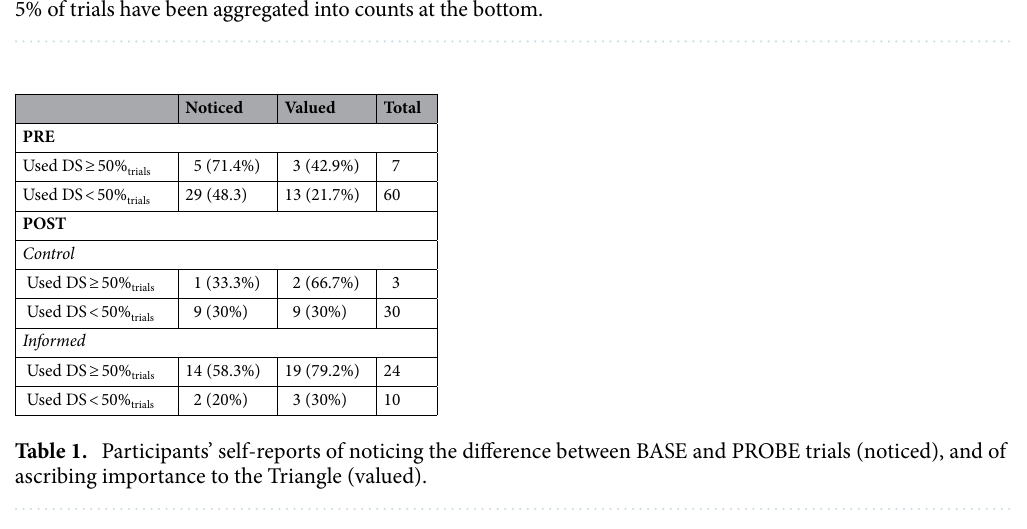
Figure 2. Shortcut-use during the LS-DS task. Mean proportion of trials that a shortcut (DS or SS) was used, for each subject in Informed and Control conditions, in PRE and POST trial blocks. Solid and dashed lines represent group means and standard deviations, respectively. Participants who used the shortcut in fewer than 5% of trials have been aggregated into counts at the bottom.